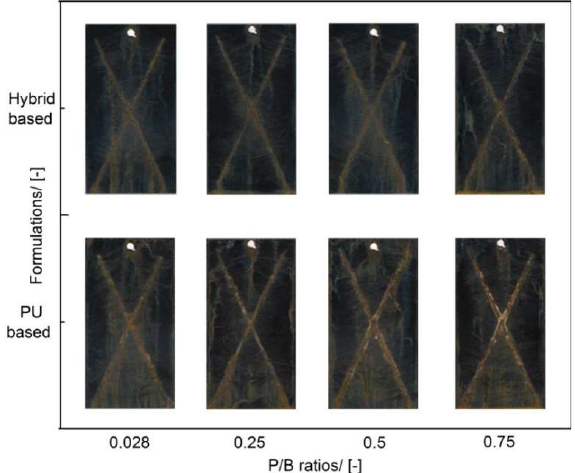
Figure 10. Aspect of the steel panels coated with powder coatings based on different resins and P/Bs after 1000 h salt spray test.